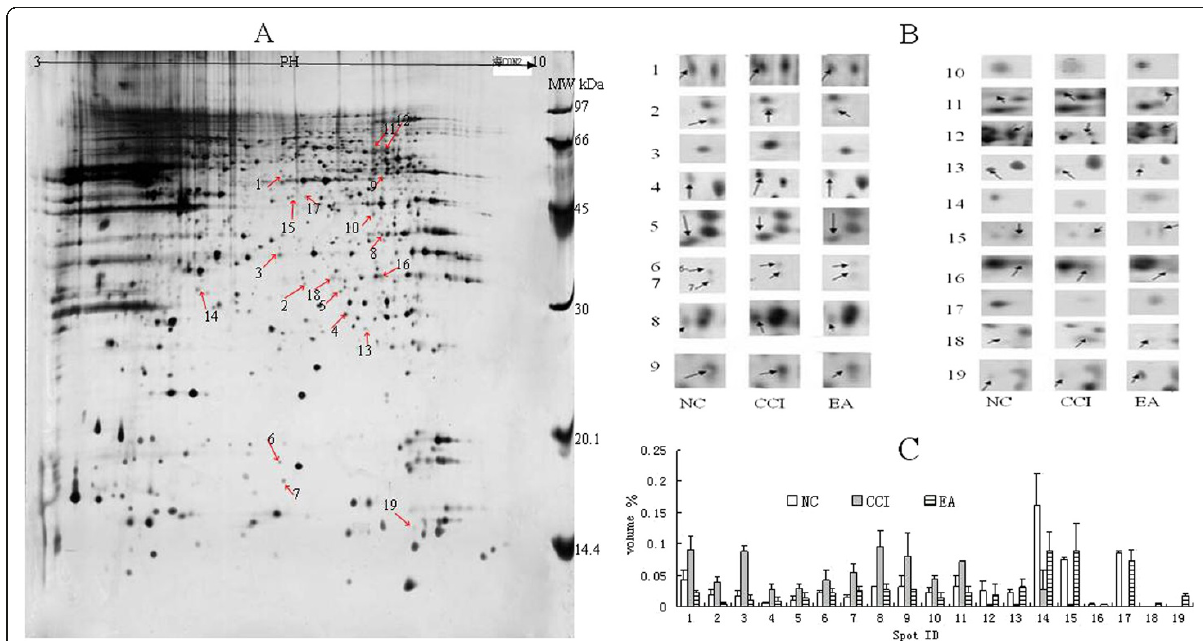
Figure 3 Expression profiles of the 19 identified differential proteins. (A) Differential expression profiles of the 19 identified differential protein spots (arrowheads) from pH 3 – 10 in 2-DE gel templates. (B) The excised protein spots from the regions of interest in A. Arrowheads represent protein spots that showed significantly different changes. Spot numbers are consistent with those shown in Table 1. (C) . Histograms of the 19 differential proteins in the three groups. Data are presented as mean ± SD (n = 10 per